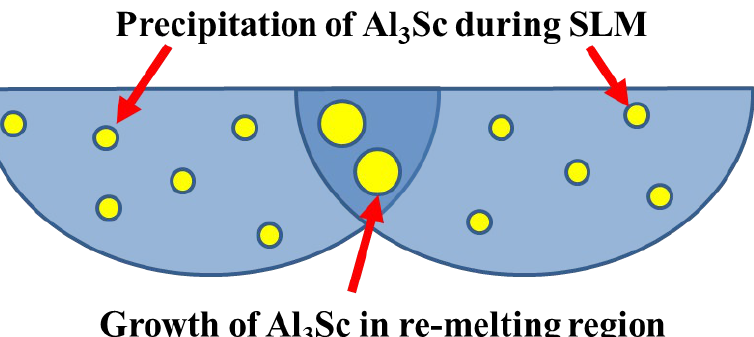
Figure 7. Schematic illustration of the precipitate size difference due to different thermal histories in the melt pool.